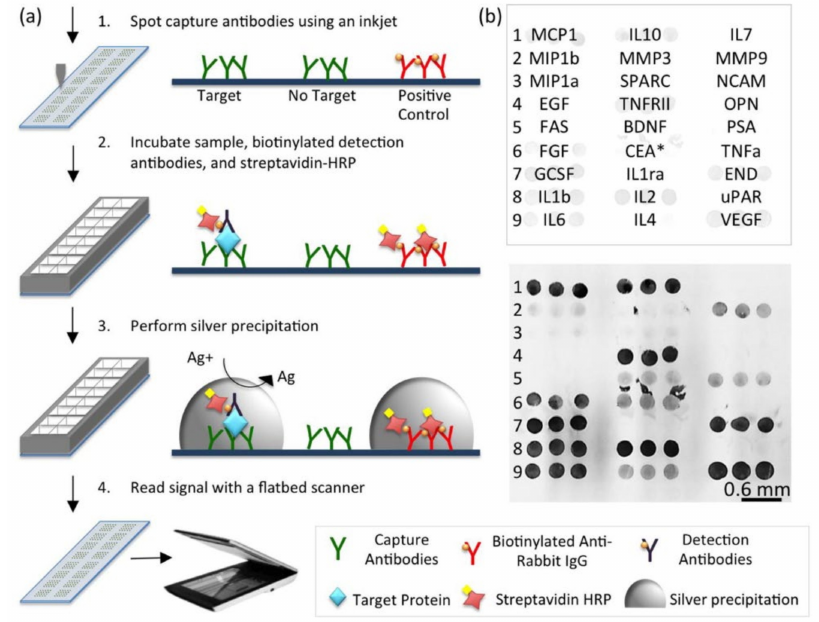
Figure 3. Schematic diagram of multiplex SENSIA. ( a ) Typical assay protocol. ( b ) Spotting pattern of capture antibodies against 27 proteins and an example assay result. Reproduced with permission from Ref [78]. Copyright 2015, American Chemical